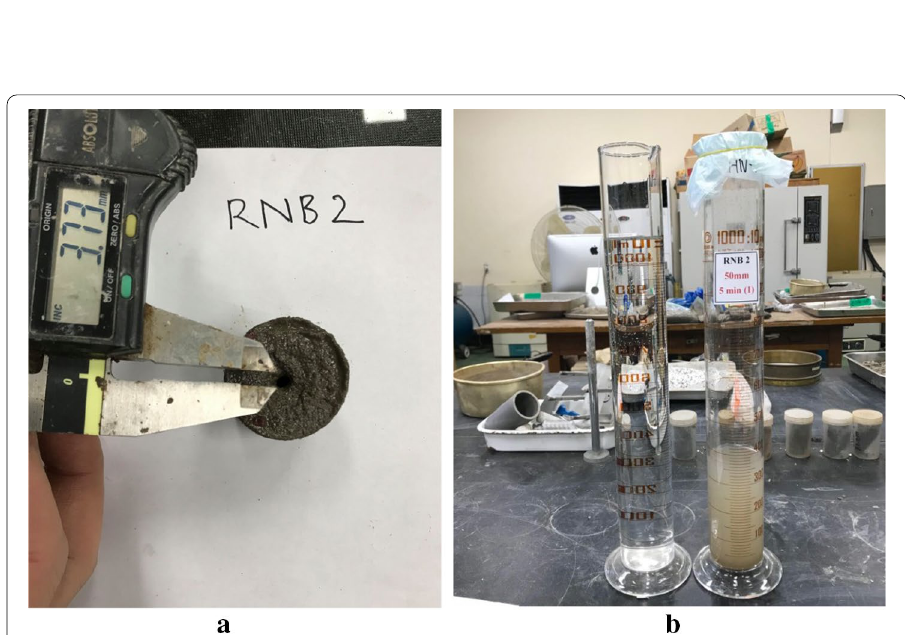
Fig. 12 a Hole size after test and b water collected from the test of SP‑SM